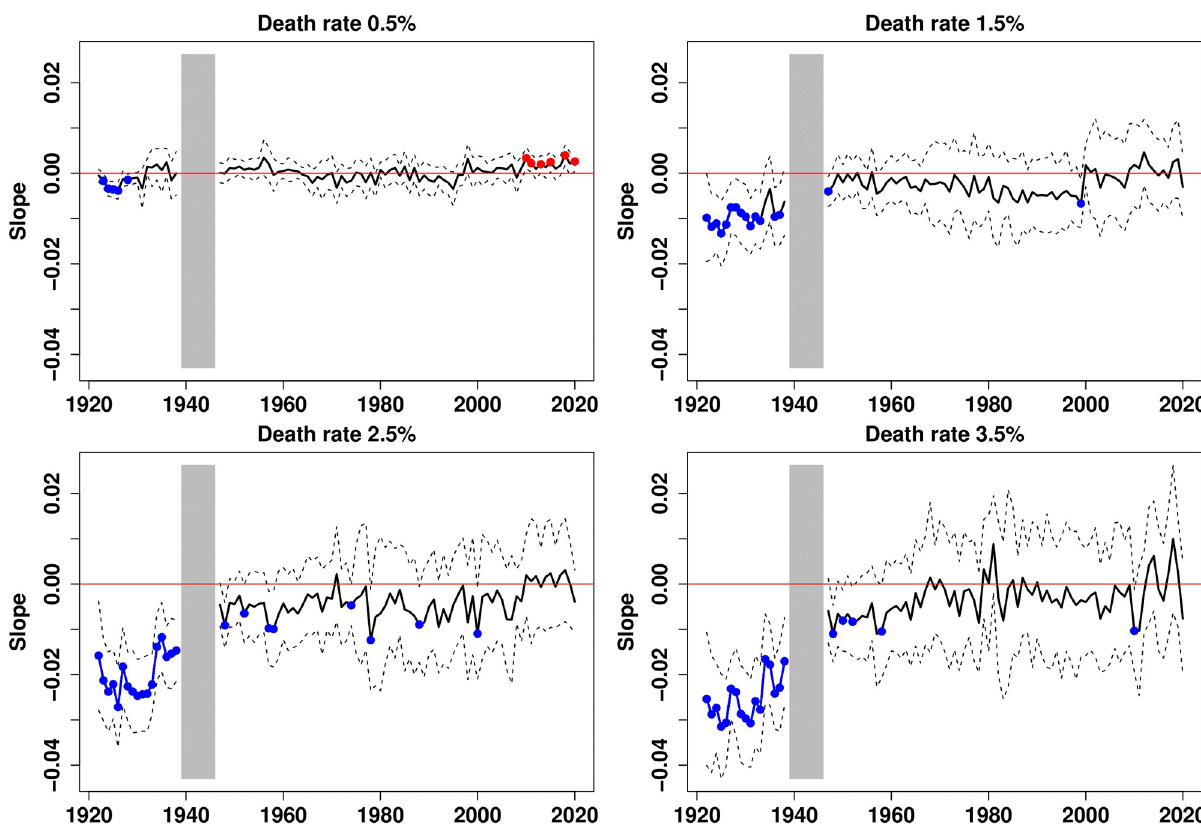
Fig 6. Income gradient in mortality for 4 mortality milestones, 1922–2020 (1922 classification). Plain curves plot the estimates of the linear trends across income groups; dotted lines are the 95% confidence intervals. Red dots indicate dates at which the slope is significantly positive, while blue dots indicate those with significantly negative slopes. Gradients are not represented for the period